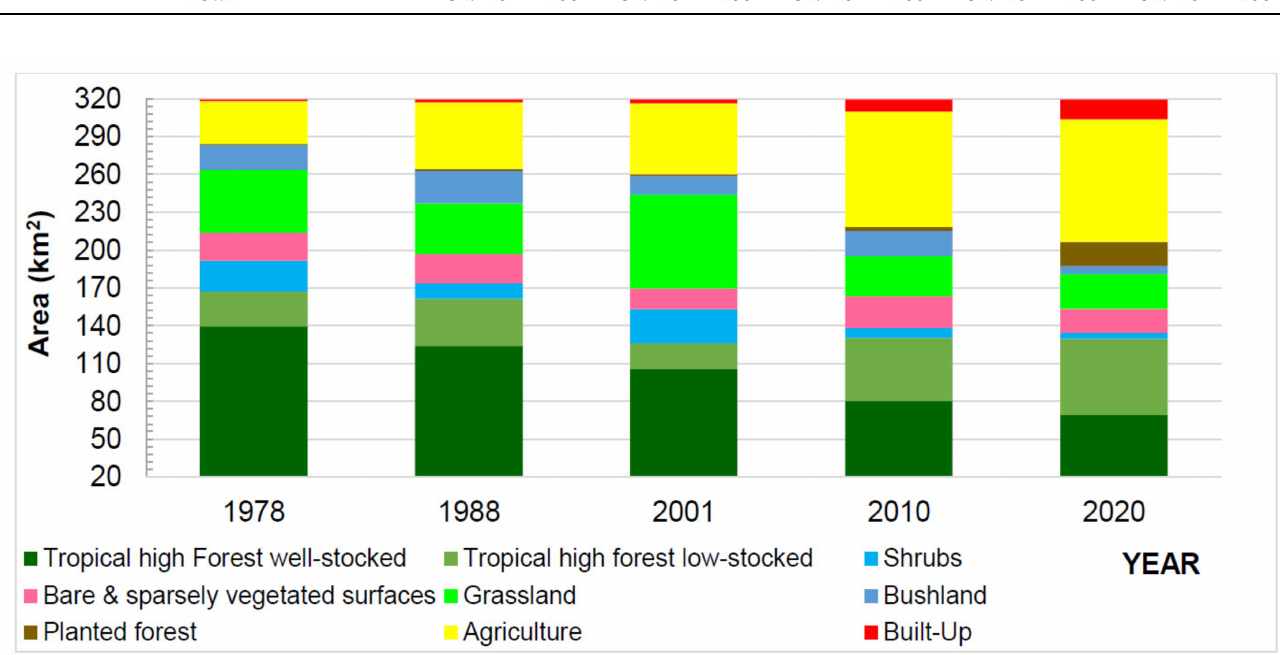
Figure 5. The amount of land cover (km 2 ) for the period from 1978 to 2020 for the upper Man- afwa watershed.